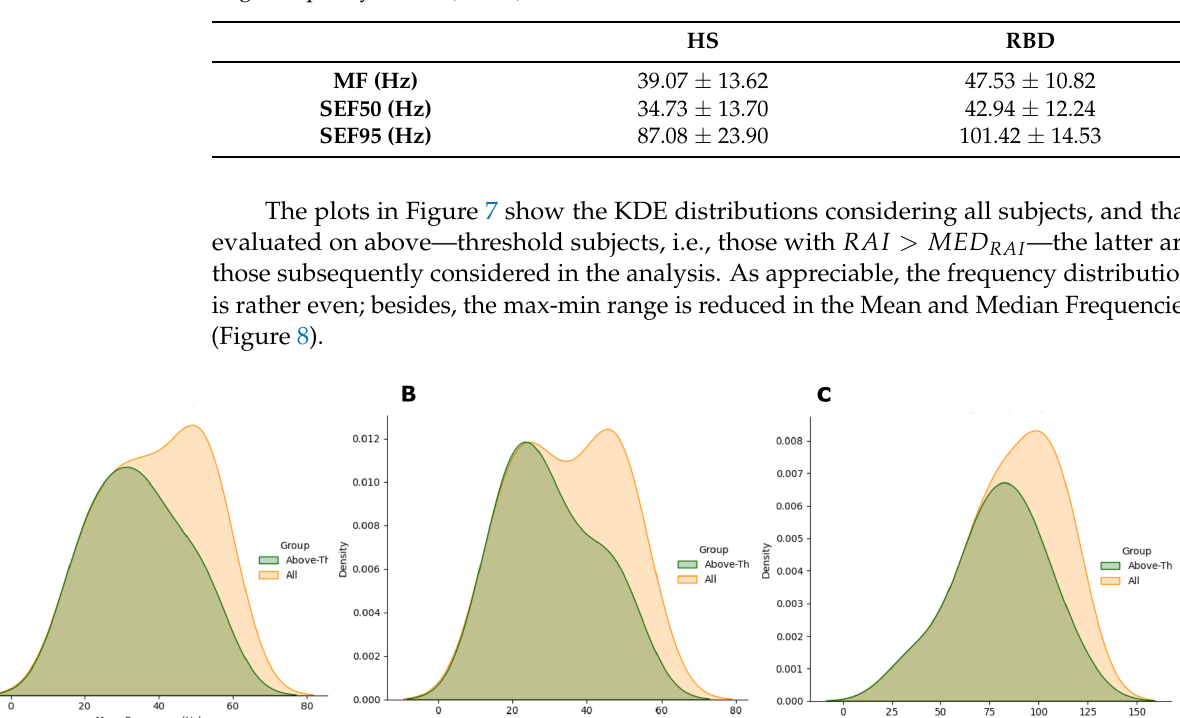
Table 4. EMG spectral features (mean ± STD), computed for the healthy (HS) and RBD subjects (RBD) in the CAP Sleep Database. Mean Frequency (MF), Median Frequency (SEF50) and Spectral Edge Frequency at 95% (SEF95).